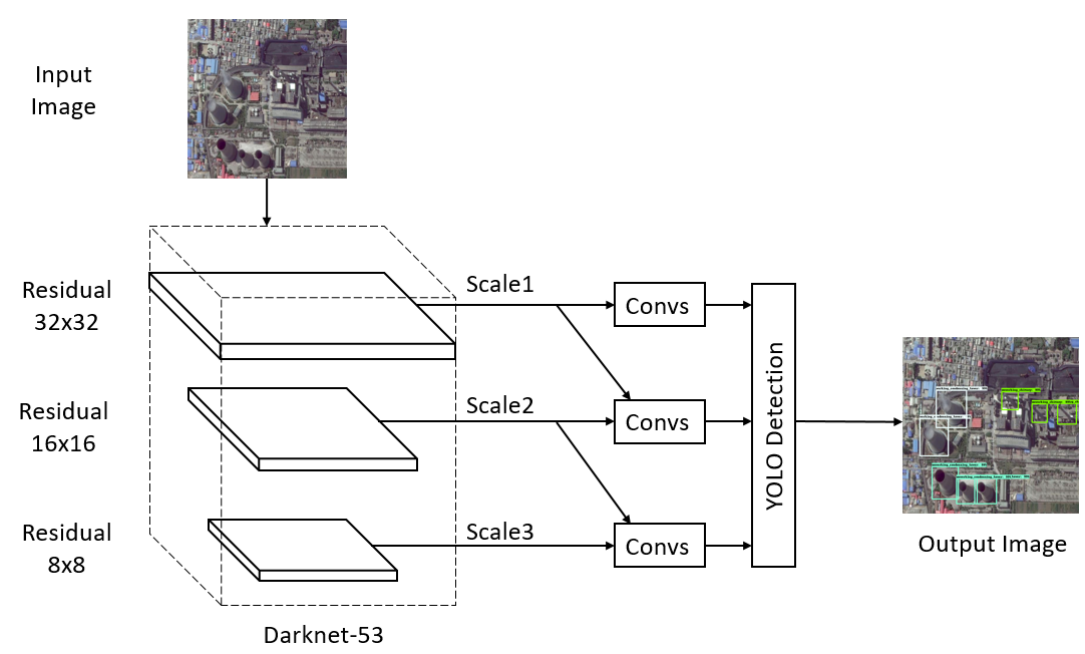
Figure 7. The framework of YOLOv3. Convs, convolutional networks.